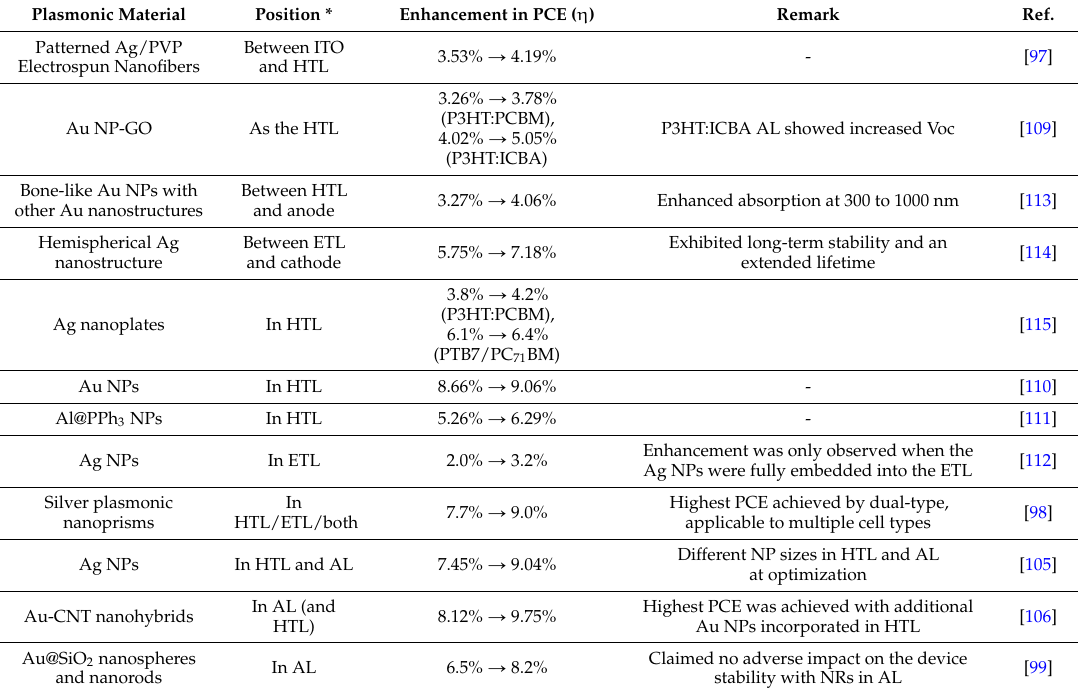
Table 2. Characteristics of plasmonic organic solar